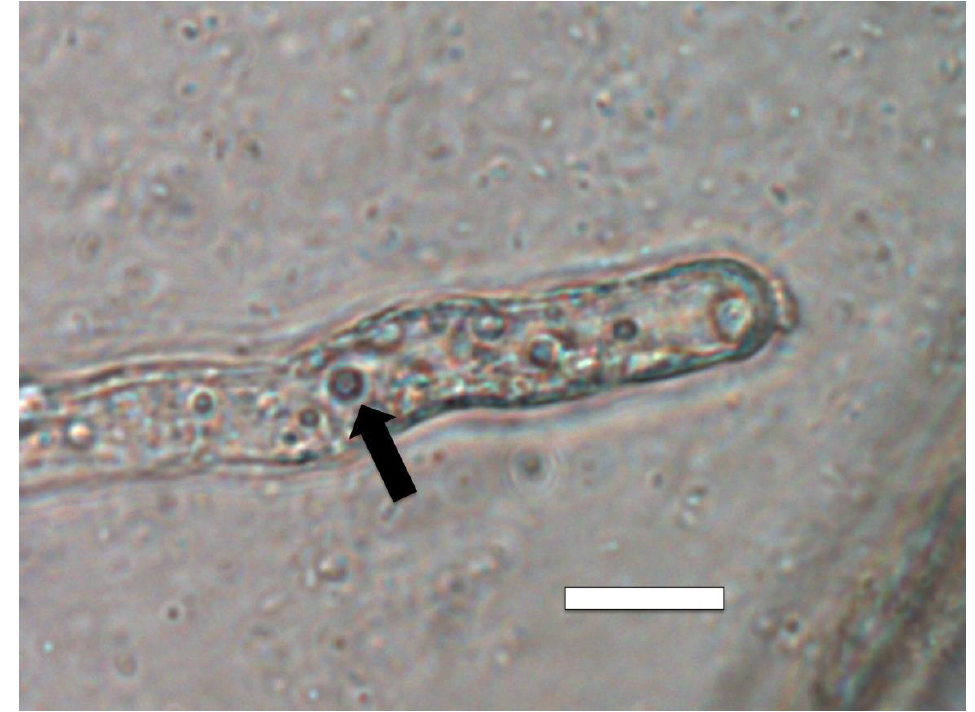
Figure 13. Intracellular bacteria (arrows) in Poa reptans root hair tips stained for nitrate (purple color) using 0.1% diphenylamine in 20% sulfuric acid. A nitrate ring (arrow) is present around bacteria in root hairs (bar = 15 µm).